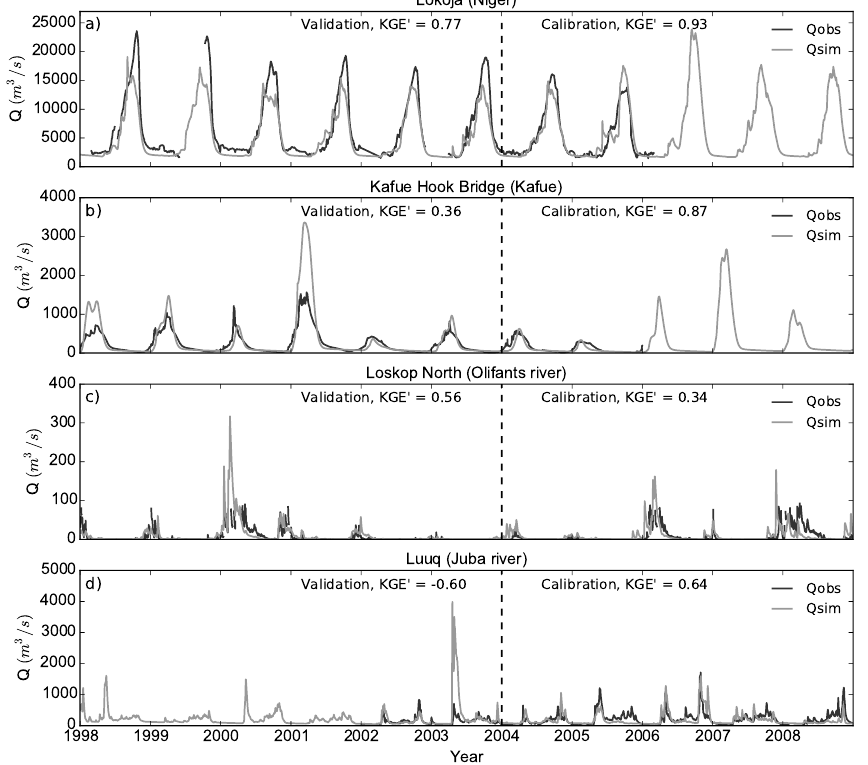
Figure 6. Comparison of daily LISFLOOD simulated (Qsim) and observed (Qobs) hydrographs during both the validation (1998–2003) and calibration period (2004–2008), for (a) Niger River at Lokoja (2174000km 2 ), (b) Kafue River at Kafue Hook Bridge (100000km 2 ), (c) Olifants River at Loskop North (15000km 2 ), and (d) Juba River at Luuq (169000km 2